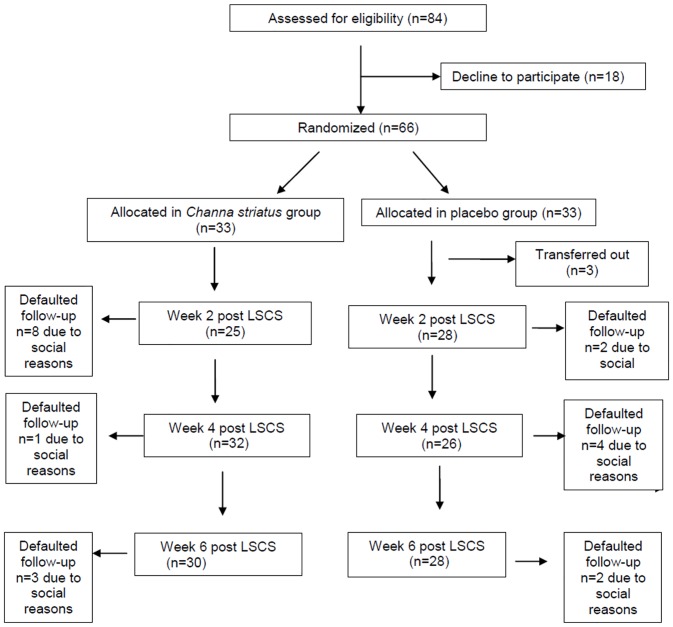
Flowchart of the study.